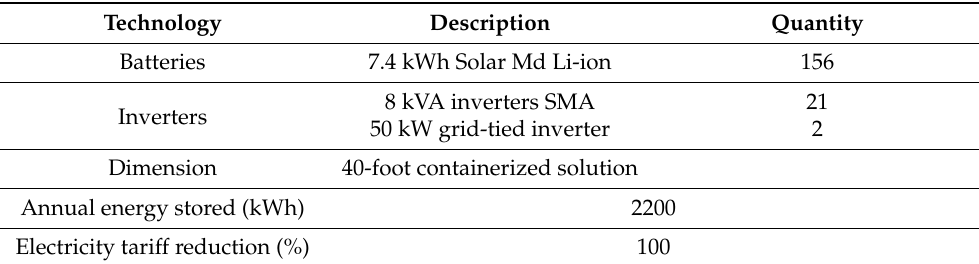
Table 5. BESS Canadian farm in Limpopo, South